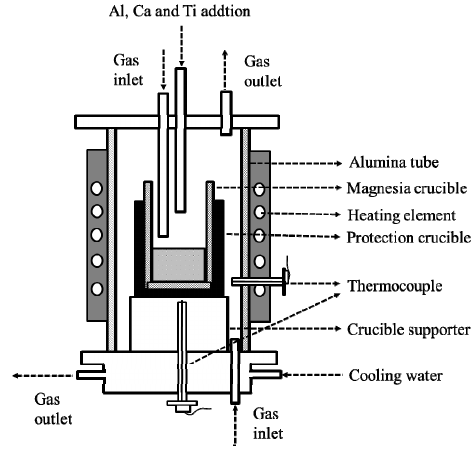
Figure 1. The schematic diagram of the experimental set-up.